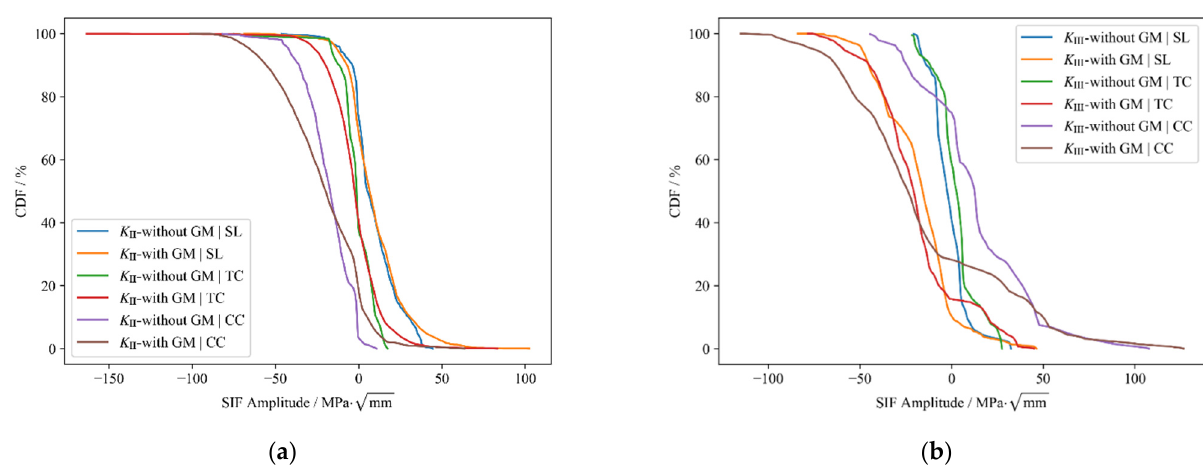
Figure 14. CDF contrast in SIFs under different conditions: ( a ) contrast in type II SIFs; ( b ) contrast in type III SIFs; GM—grinding marks; SL—straight line; TC—transition curve; CC—circular